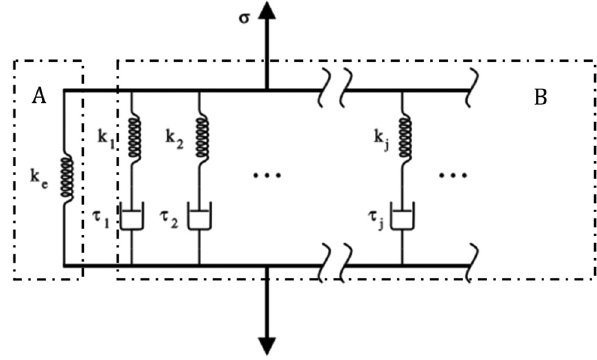
Figure 3: The mathematic model for UD composites in 1